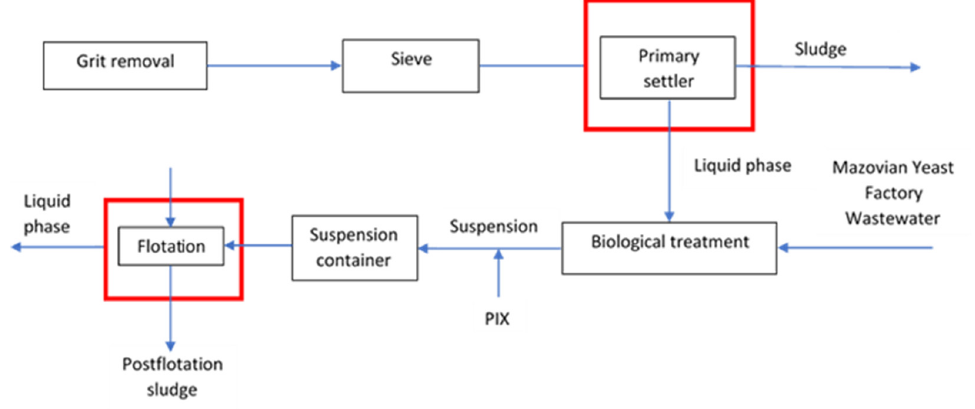
Figure 2. Simplified scheme of WWTP1. Sampling points are marked with red frames.